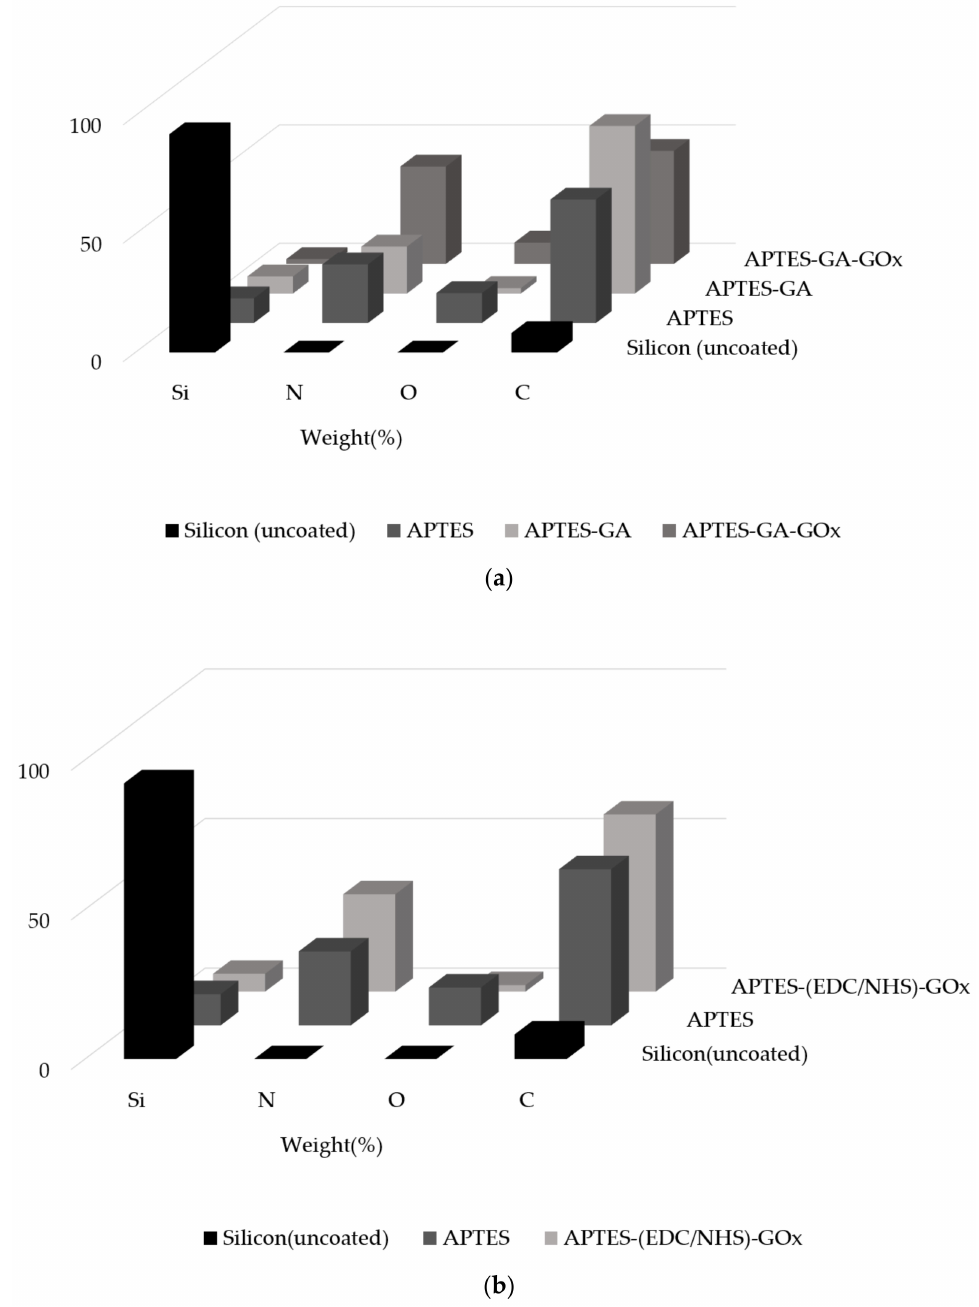
Figure 11. Element composition after each step of GOx coating using ( a ) APTES-GA technique and ( b ) APTES- (EDC/NHS)